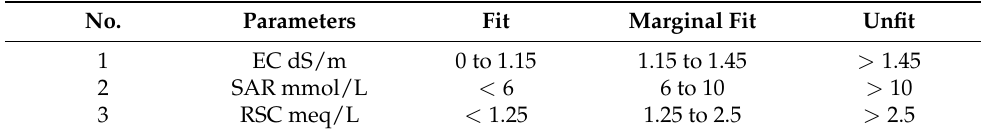
Table 1. Criteria for the qualification of irrigation water for fitness.